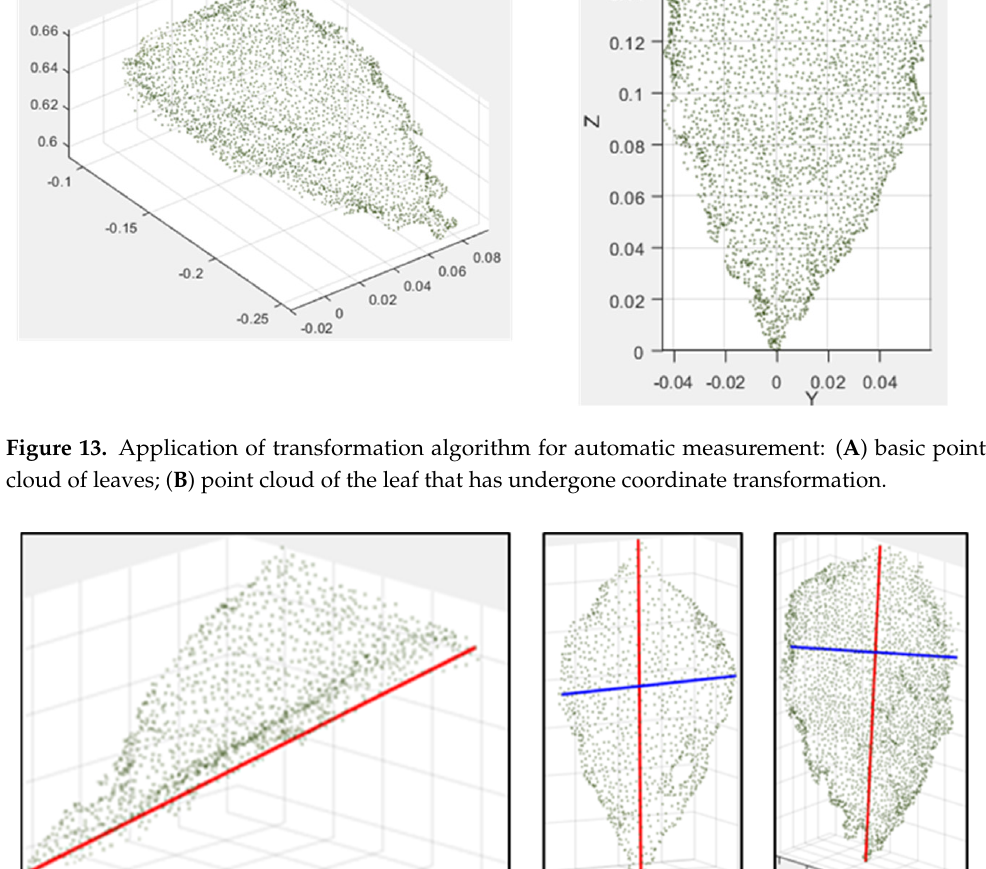
Figure 14. Automatic measurement of length and width for segmented leaves.